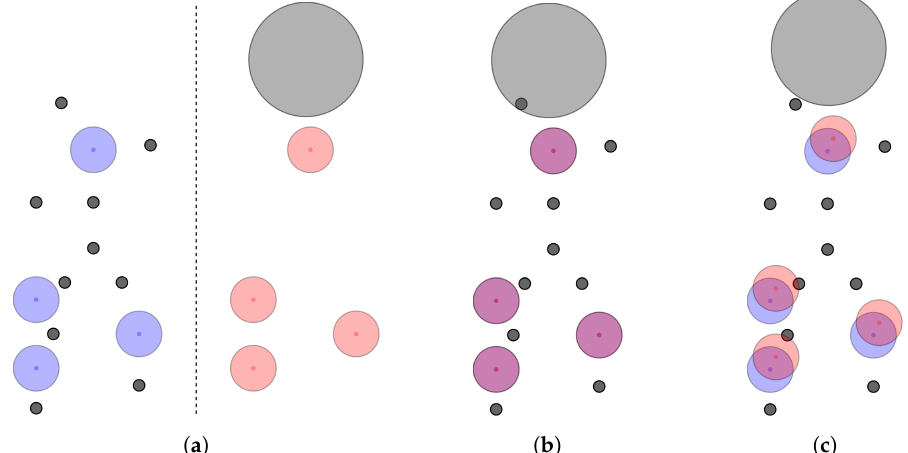
Figure 4. Illustration of exclusion volume clashes leading to an invalid alignment. For the sake of simplicity, pharmacophores ( a ) consist only of features of the same type and atoms of one pharma- cophore, shown as black circles. After an alignment of the pharmacophores, atoms may clash with exclusion volumes ( b ), which can sometimes be fixed with a simple translation ( c